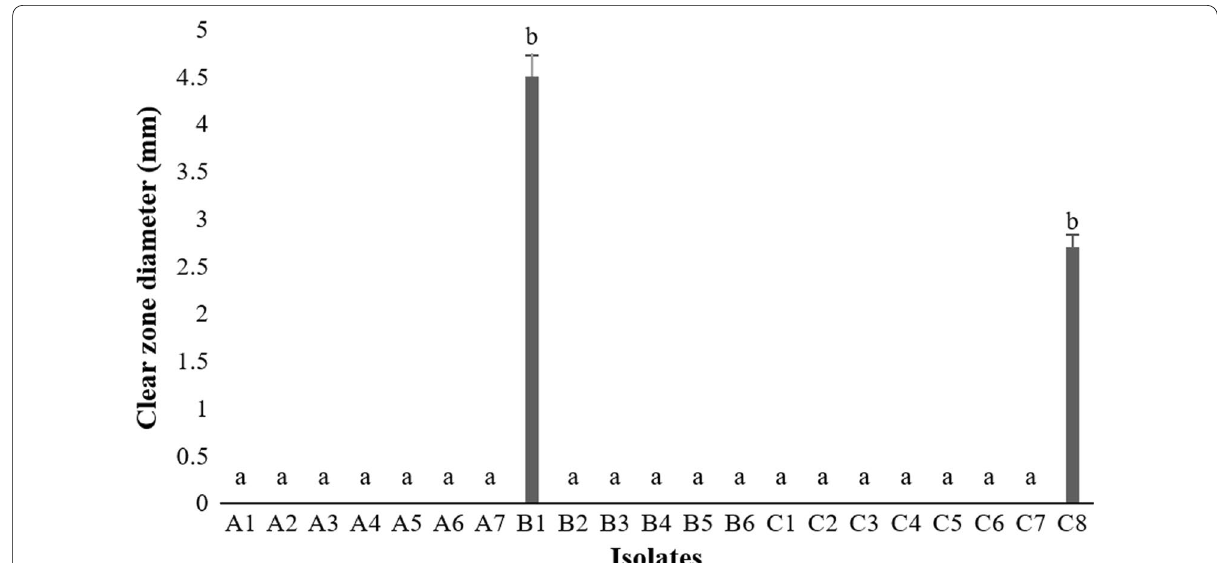
Fig. 1 Inhibitory activities of Rangpur lime endophytic bacteria against XCC. Different letters on each histogram indicated any difference in clear zone diameter among bacterial isolates ( p <